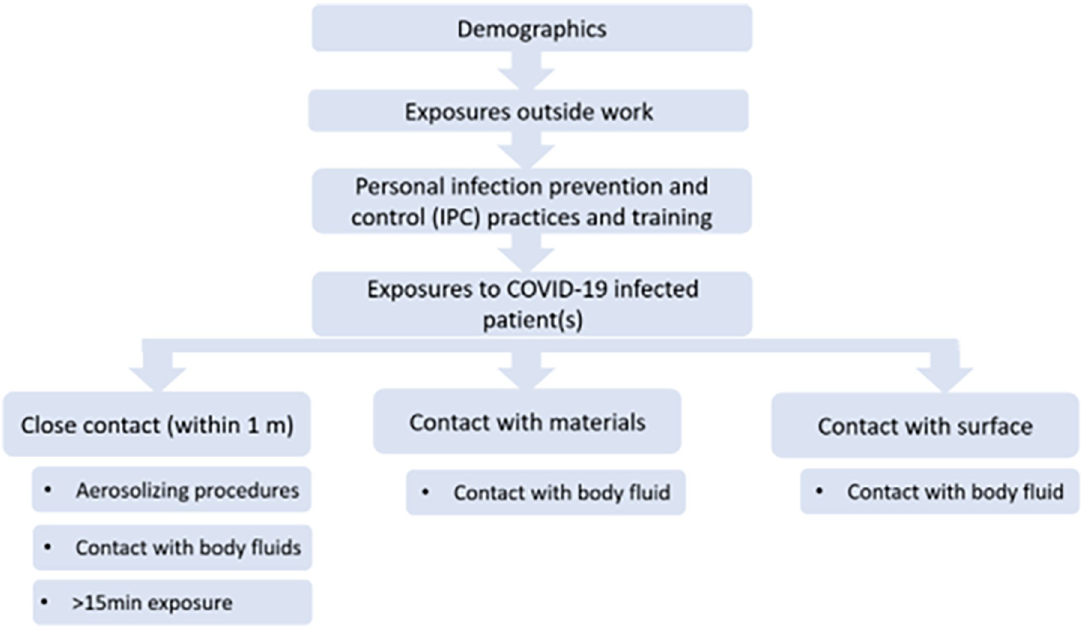
Fig 1. Questionnaire